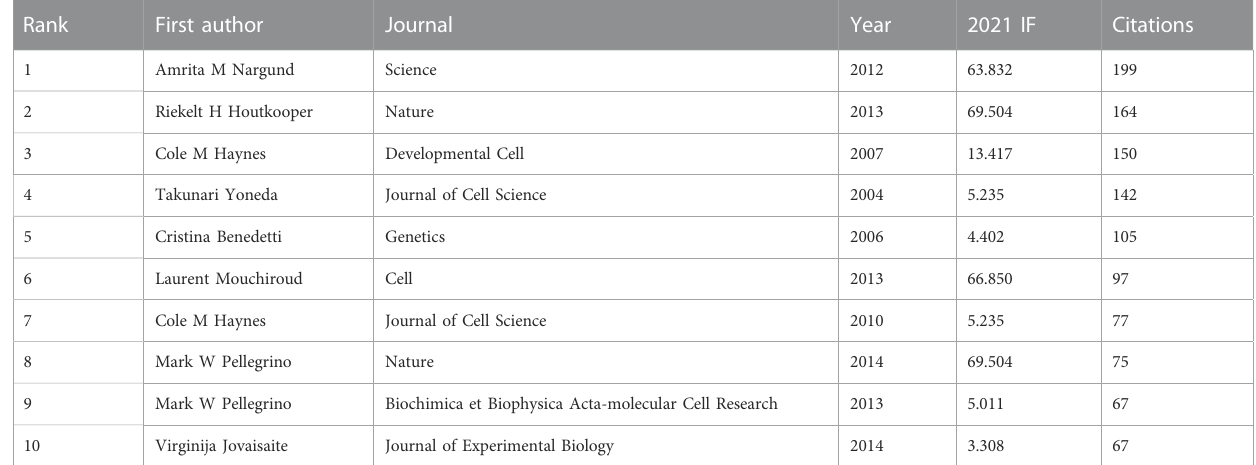
TABLE 3 Top 10 highest citation publications in the fi eld of UPR mt